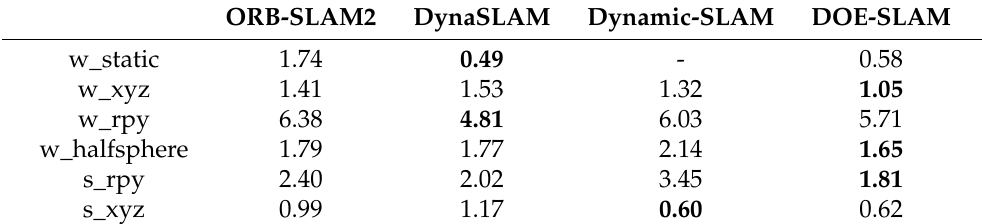
Table 4. Comparison of the RMSE of ATE (cm) in selected TUM datasets.